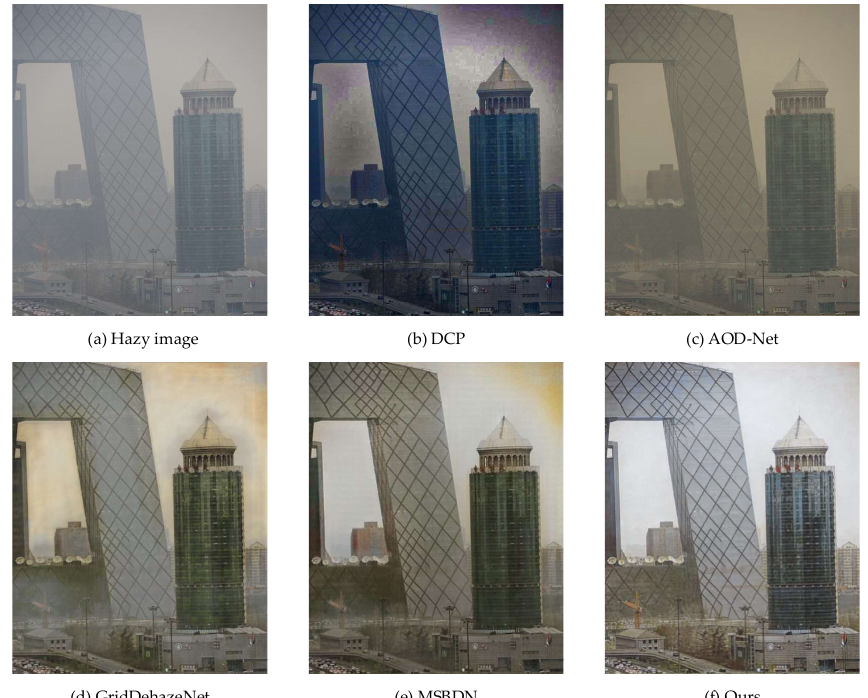
Figure 8. Visual quality comparison of natural hazy image.